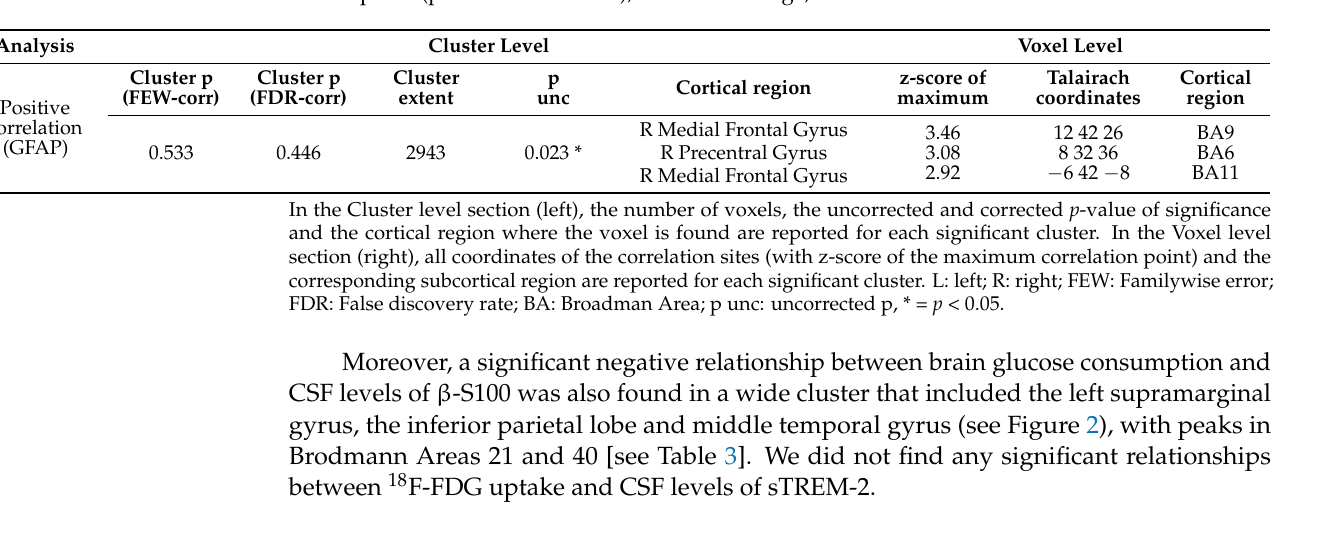
Figure 1. Three-dimensional brain rendering showing clusters obtained in SPM regression analysis for the positive correlation between CSF GFAP and glucose 18 F-FDG uptake (see Table 2). Table 2. Multiple regression analysis showing the CSF GFAP related areas of increased 18 F-FDG brain uptake (positive correlation), corrected for age, sex and CSF levels of t-tau.